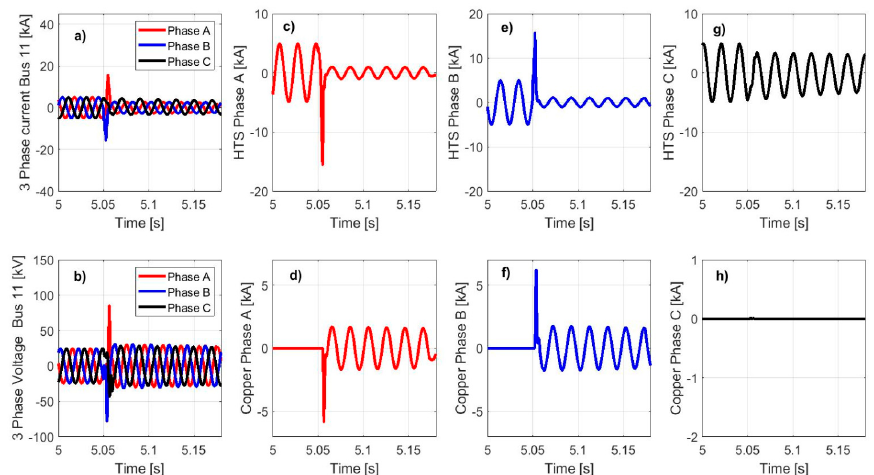
Figure 12. Fault current signatures for Phase-A-to-ground Phase-A-B-to-ground solid fault at 50% of cable’s length: ( a ) phase currents at Bus 11, ( b ) phase voltages at Bus 11, ( c ) current in HTS layer of phase A, ( d ) current in copper layer of phase A, ( e ) current in HTS layer of phase B, ( f ) current in copper layer of phase B, ( g ) current in HTS layer of phase C, ( h ) current in copper layer of phase C.